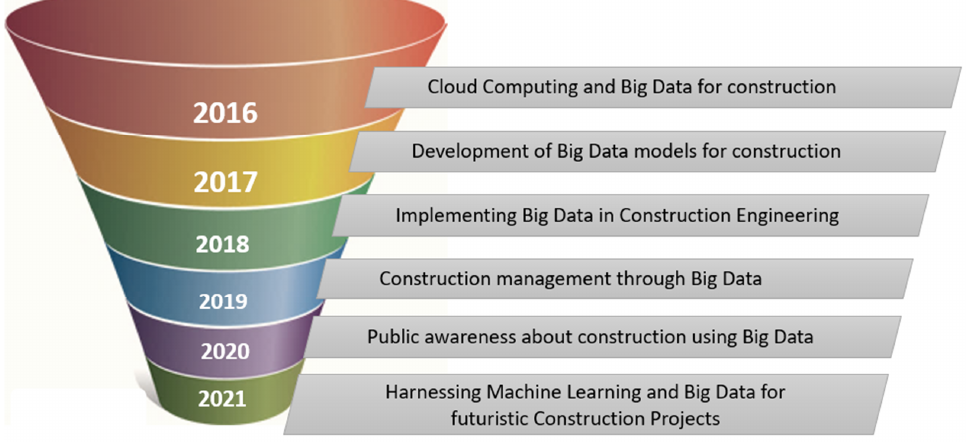
Figure 1. Funnel diagrams showing trends in big data research in construction since 2016.